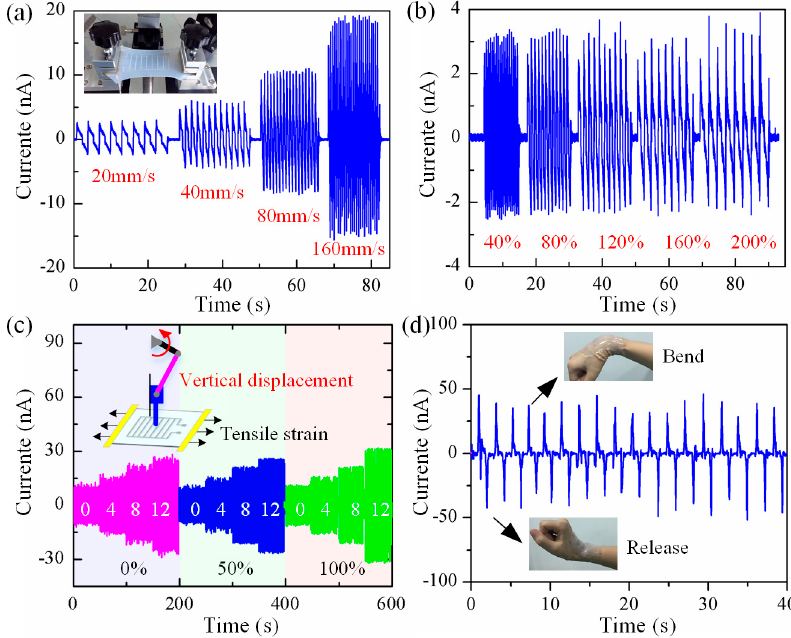
Figure 5. ( a ) The output current of 120% stretching in uniaxial direction under 20, 40, 80 and 120 mm/s; ( b ) The output current of 40, 80, 120, 160 and 200% stretching in the uniaxial direction, under the same velocity of 40 mm/s; ( c ) Current output of a freestanding nanogenerator subjected to various vertical displacement (0, 4, 8 and 12 mm) under different applied strains (0%, 50% and 100%); ( d ) The electrical output for monitoring human wrist movement.